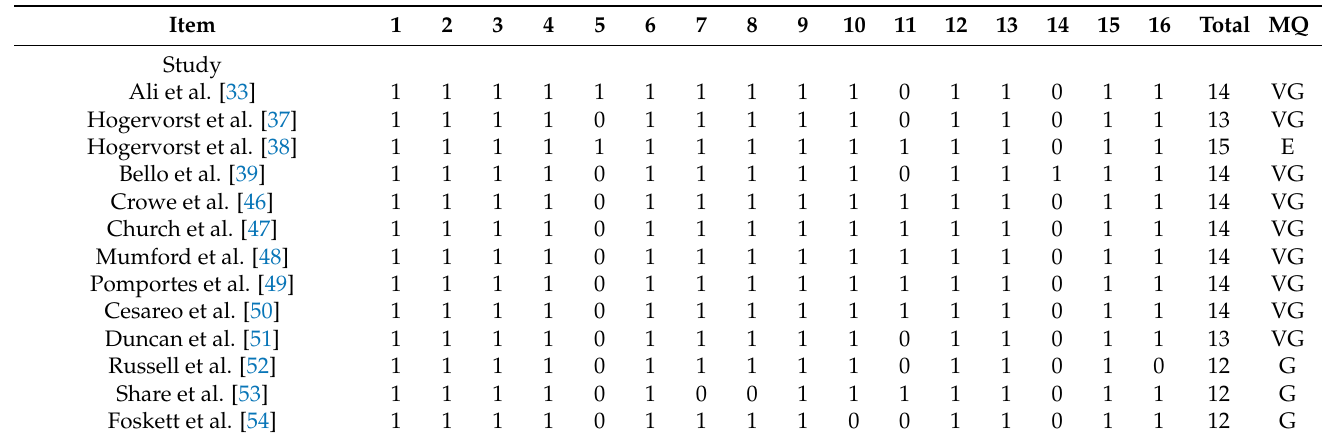
Table 4. Methodological quality of the studies ( n =